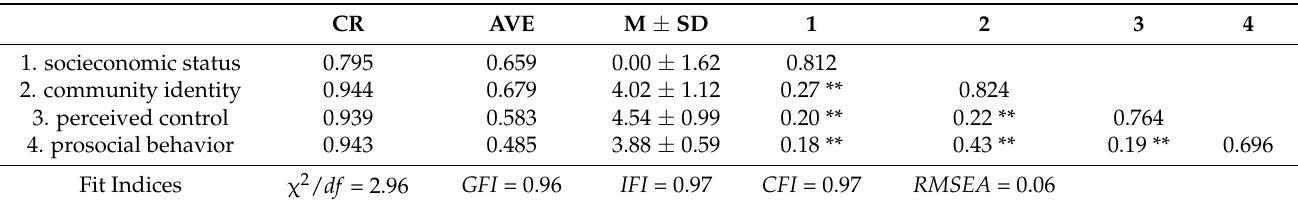
Table 2. Descriptive statistics, inter-correlations, composite reliability, average variance extracted, and fit indices of the major variables.